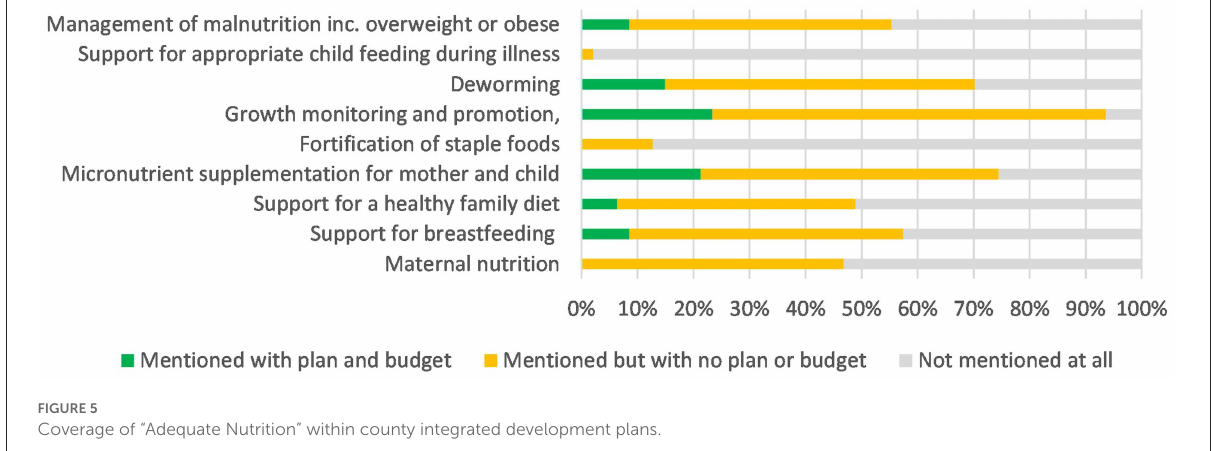
FIGURE5 Coverage of “Adequate Nutrition” within county integrated development plans.